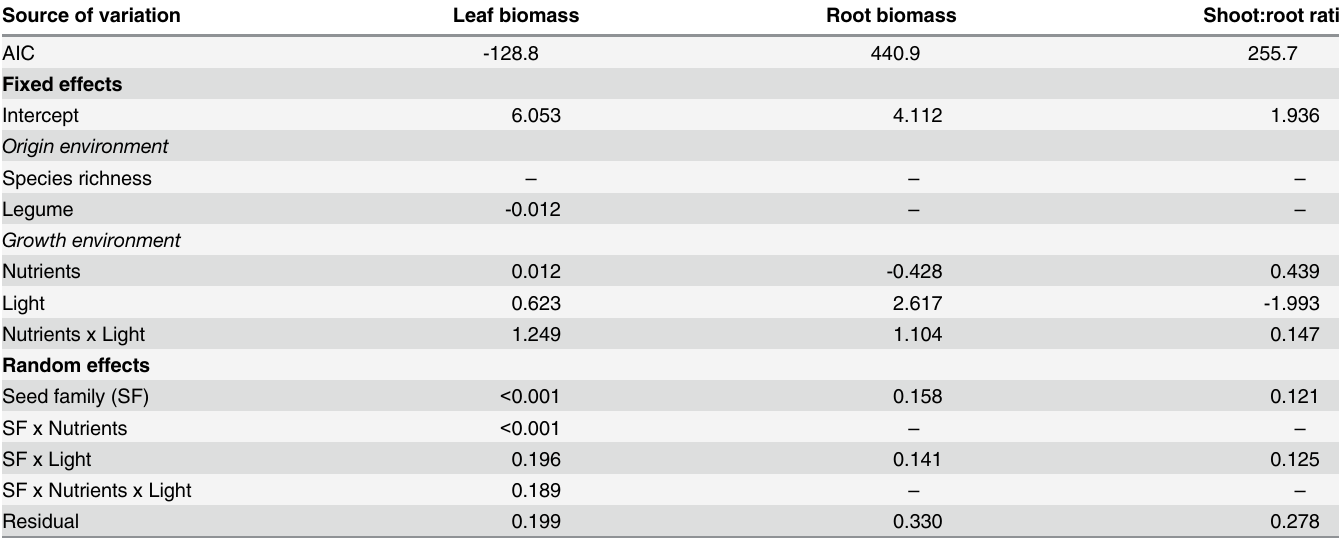
Table 2. Summary of mixed-effects model analyses of leaf and root biomass and the shoot: root ratio measured for Plantago lanceolata . Plants were grown at two different levels of nutrient and light availability and originated from seed families collected in experimental communities of different plant diversity.